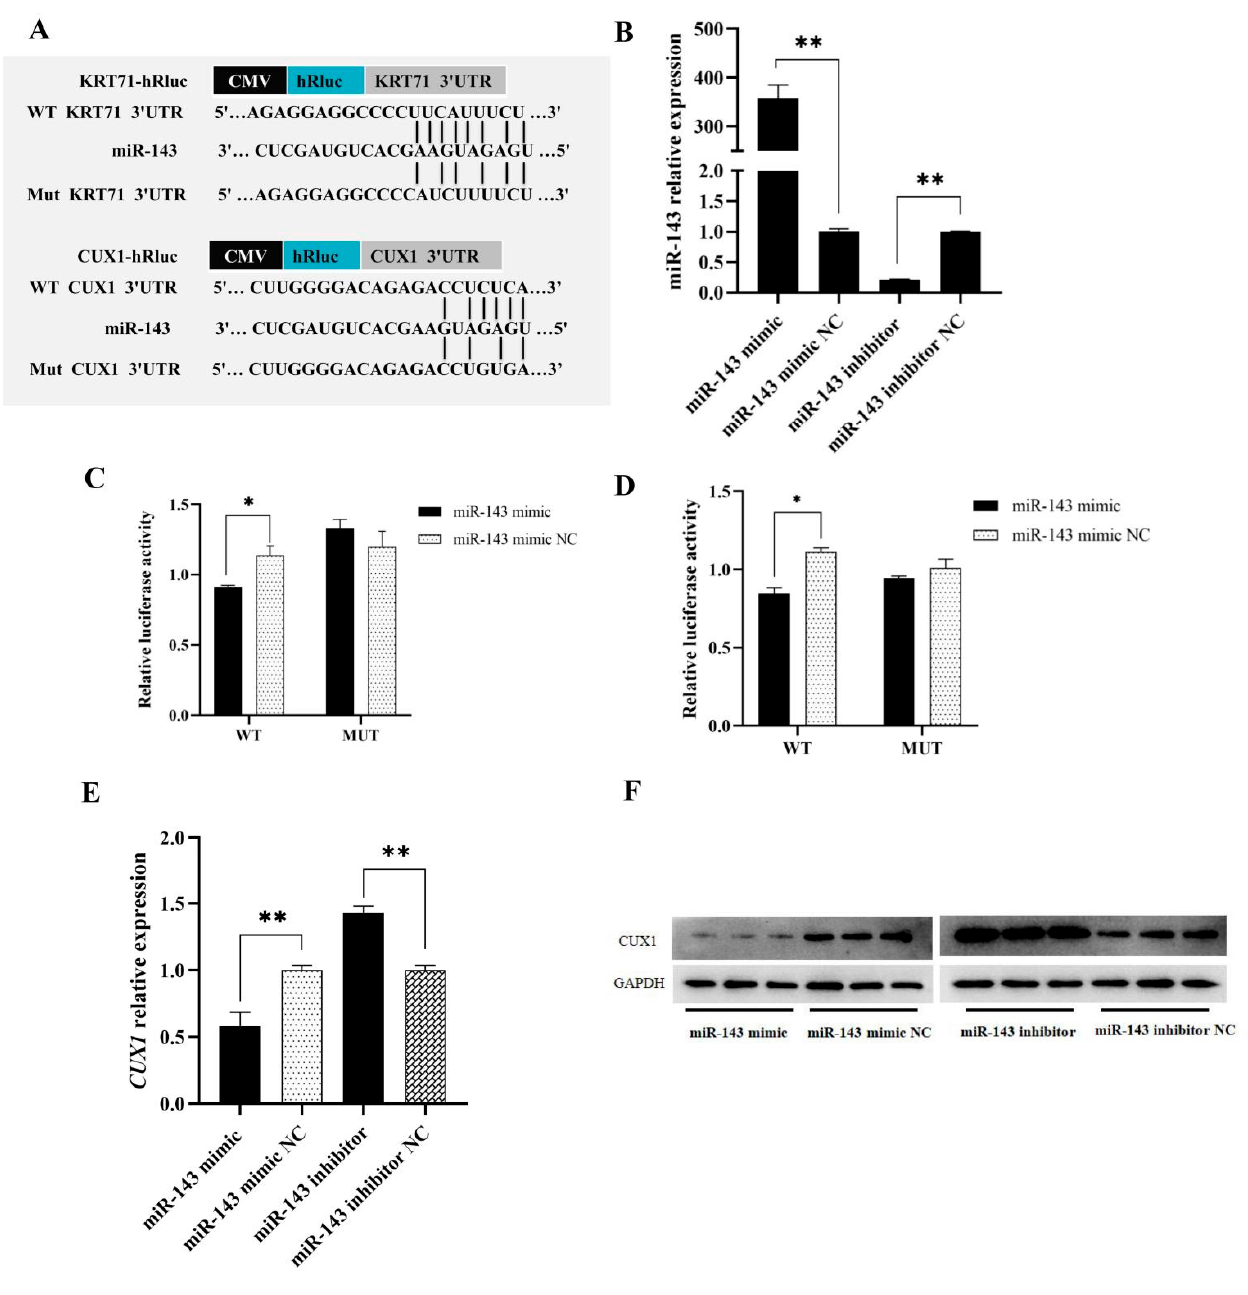
Figure 3. Target validation between miR-143 and KRT71 and CUX1 : ( A ) Target gene prediction of miR-143. ( B ) The transfection efficiency verification of miR-143 mimic and inhibitor in dermal papilla cells. ( C , D ) The dual-luciferase assay between miR-143 and KRT71 and miR-143 and CUX1 in 293T cell. ( E ) Overexpression and inhibition of miR-143 in dermal papilla cells. ( F ) Detection of CUX1 protein expression level. * p < 0.05 or ** p < 0.01.